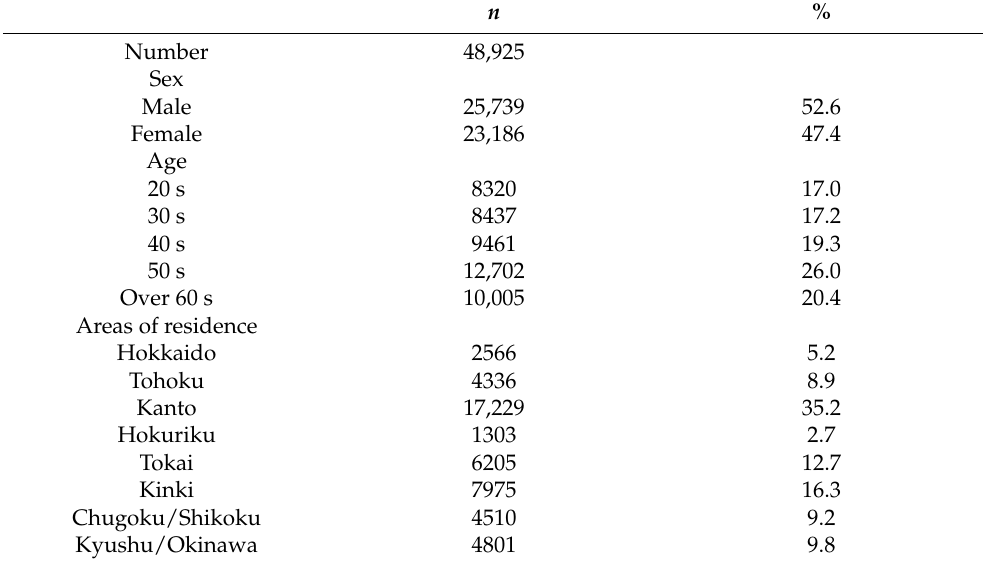
Table 1. Characteristics of